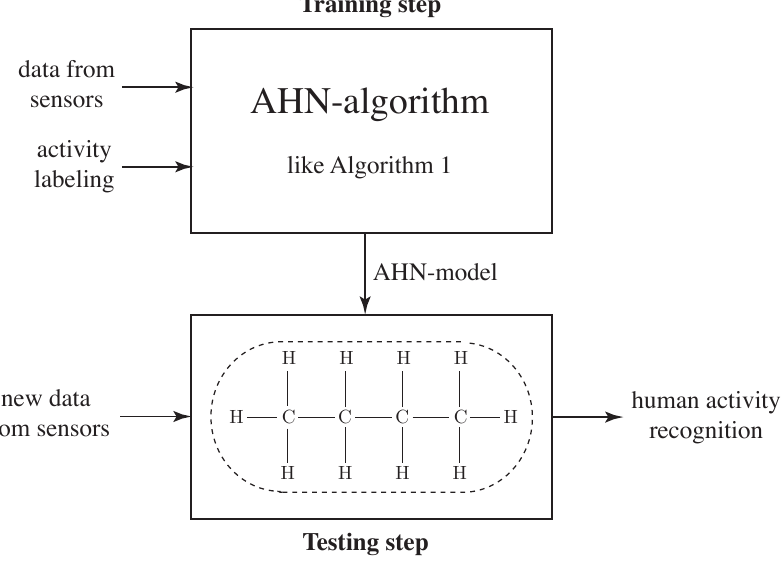
Figure 2. Diagram of the proposed artificial hydrocarbon network based classifier (AHN-classifier). First, reduced feature set is used to train the AHN-model, then it is used as AHN-classifier in the testing